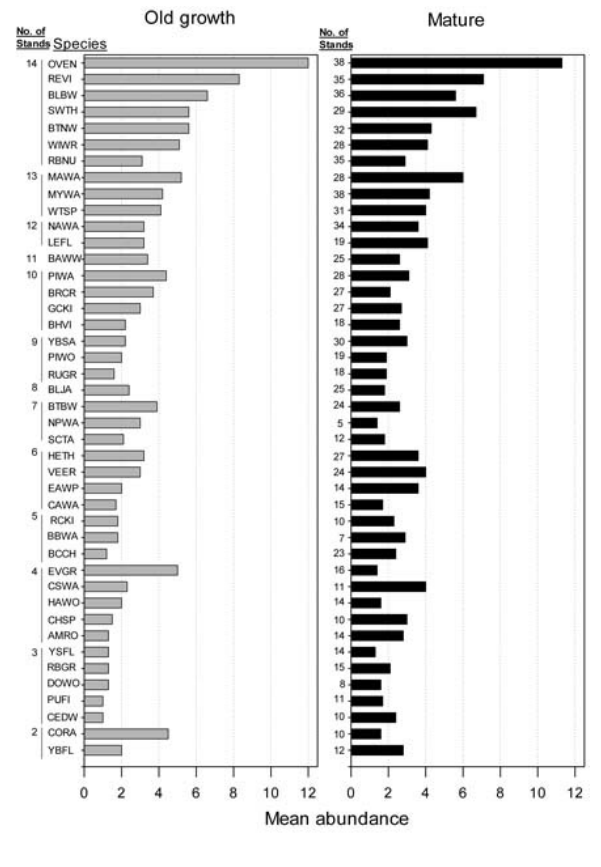
Fig. 2 . Mean abundance of 43 bird species (>20% of stands) in old-growth stands (>130 years old) and mature stands (<130 years old), and the number of stands in which they were observed. Species codes are in Appendix